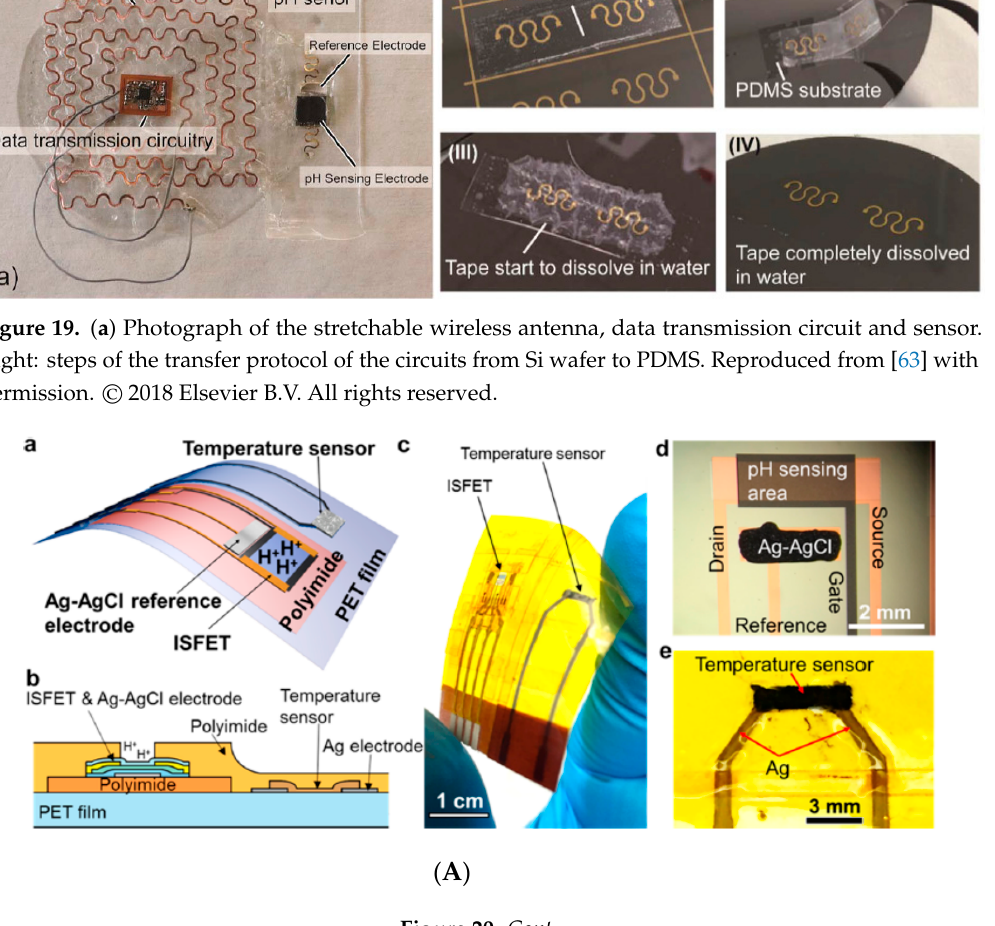
( B ) (C) Figure 20. ( A ) a—Scheme of the flexible strip integrating pH and temperature sensors; b—Side view of the encapsulated sensors; c—Picture of the strip held between two fingers. d, e—Details of the two sensors. ( B ) Real-time pH and skin temperature acquired from the neck of a patient, by the device (continuous lines) and measured by commercial pH and infrared sensors (squares and circles). ( C ) a—Picture of the complete strip under bending (r: curvature radius). b, c—Normalized ISFET current as a function of curvature radius and during 1600 bending cycles at a radius of 32.5 mm. Reproduced from [64]. Copyright © 2017, American Chemical Society. 3.2. Skin Hydration The measurement of skin hydration is very important because hydration influences many essential functions of the skin such as mechanical resistance and barrier function. As a consequence, skin hydration plays also a role in the efficiency of drug delivery through the skin, and therefore in the efficiency of chemical skin sensors. In addition, it also plays a role in visual appearance and is therefore an important parameter considered by the cosmetic industry. Indeed, skin being our